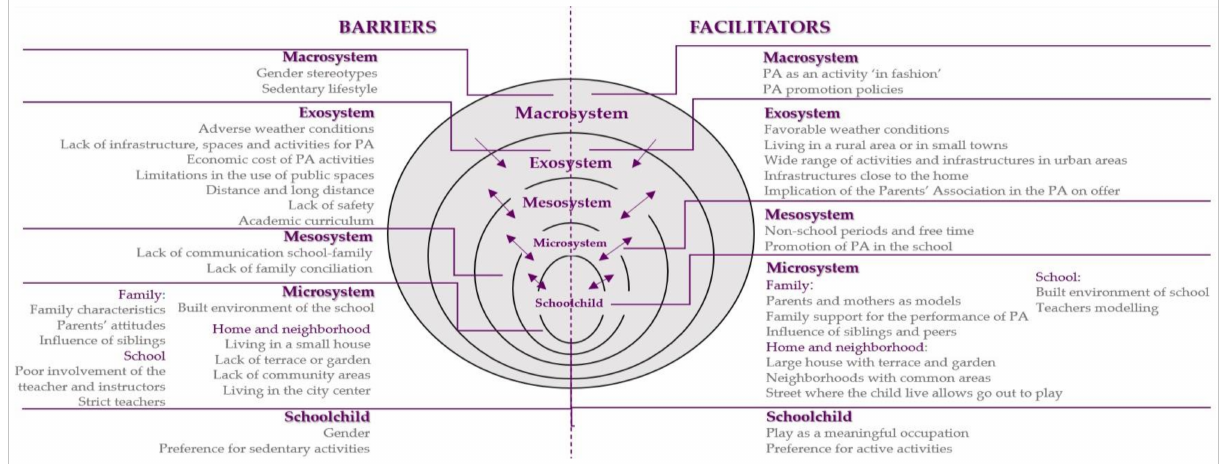
Figure 1. Barriers and facilitators to physical activity for schoolchildren: Diagram of categories and subcategories. Note: Adapted from the socio-ecological